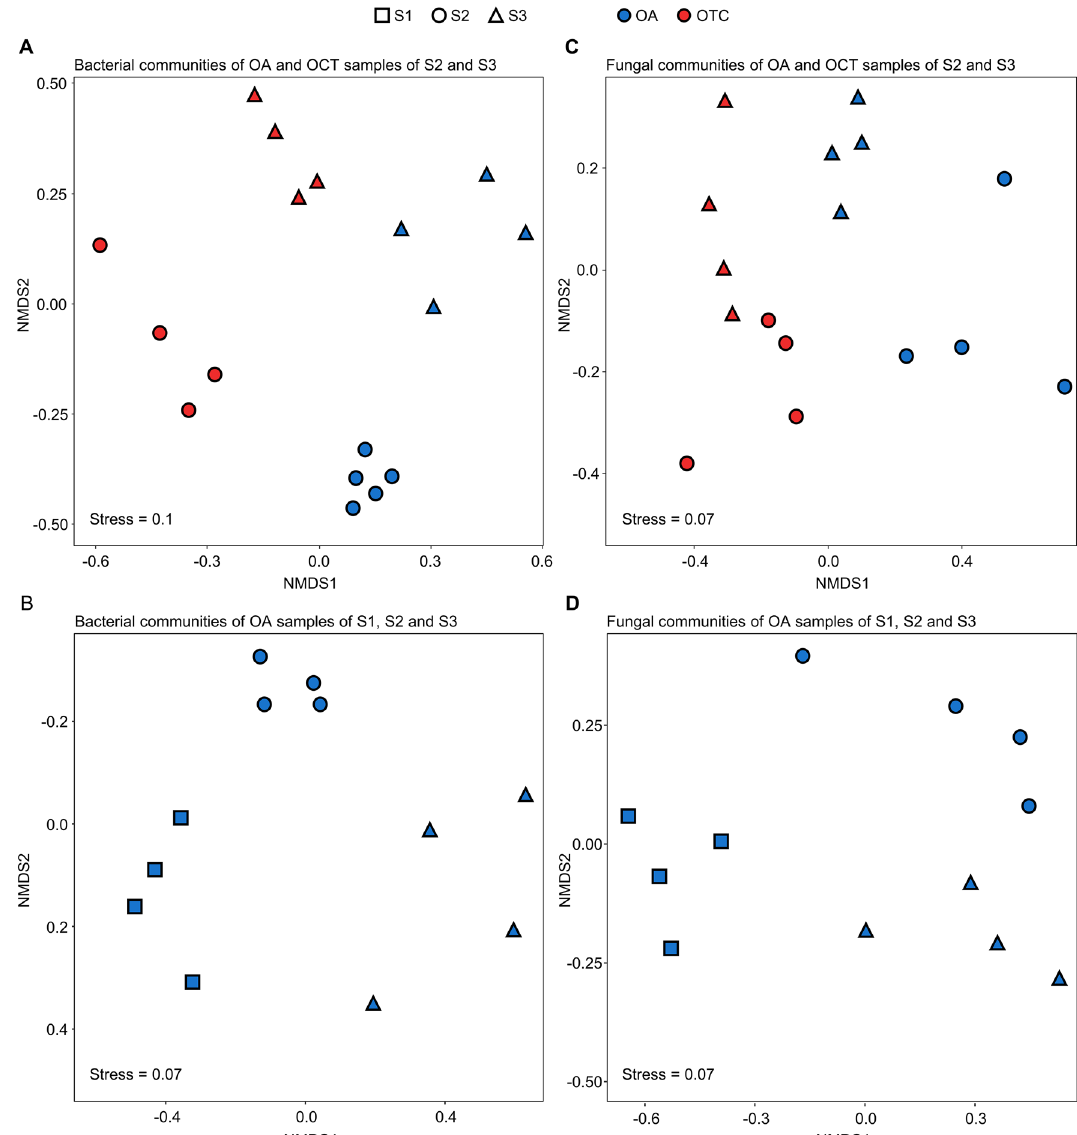
Figure 1. Non-metric multidimensional scaling (NMDS) endophytic bacterial ( A , B ) and fungal ( C , D ) communities of Colobanthus quitensis . NMDS plots are reported for amplicon sequence variants (ASVs) obtained from C. quitensis leaves collected in open areas (OA samples; blue) of the Antarctic site 1 (S1; square), site 2 (S2; circle), and site 3 (S3; triangle) or inside open-top chambers (OTC samples; blue) that were available in two sites (S2 and S3). Since OTCs were not available in S1, two datasets were analyzed: OA and OTC samples collected from S2 and S3 ( A , C ) or OA samples collected from S1, S2, and S3 ( B , D ). NMDS stress values are reported on each panel. Significant effects of the presence of OTCs and the collection site were found according to the permutational multivariate analysis of variance (Supplementary Table (Fig. 1C). However, the effect of the collection site on fungal communities was better highlighted in the NMDS plot of OA samples collected from S1, S2, and S3 (Fig. 1D). The permutational multivariate analysis of variances (PERMANOVA) on Bray–Curtis dissimilarities con- firmed significant differences in bacterial communities according to the presence of OTCs ( P = 0.001, pseudo F = 3.70, R2 = 0,18 and Df = 1) and to the collection site ( P = 0.001, pseudo F = 2.87, R2 = 0.14 and Df = 1) in the dataset of OA and OTC samples collected from S2 and S3, with a contribution of 14.1% and 18.3% on the beta- diversity, respectively (Supplementary Table 5a). The collection site affected ( P = 0.002, pseudo F = 3.34, R2 = 0.43 and Df = 2) bacterial communities (contribution of 42.6% on the beta-diversity) when OA samples collected from S1, S2, and S3 were analyzed as second dataset (Supplementary Table 5b). In agreement with the NMDS plot, fungal communities differed according to the presence of OTCs (contribution of 47.8% on the beta-diversity) in the dataset of OA and OTC samples collected from S2 and S3 ( P = 0.001, pseudo F = 14.8, R2 = 0.48 and Df = 1; Supplementary Table 5c), and according to the collection site (contribution of 56.6% on the beta-diversity) in